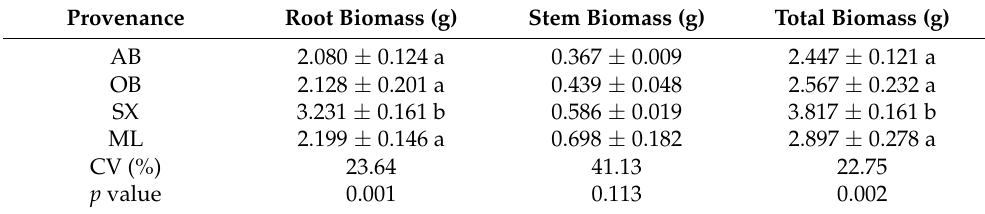
Table 9. Seedling root biomass, stem biomass, and total biomass of four provenances of X. sorbifolium .